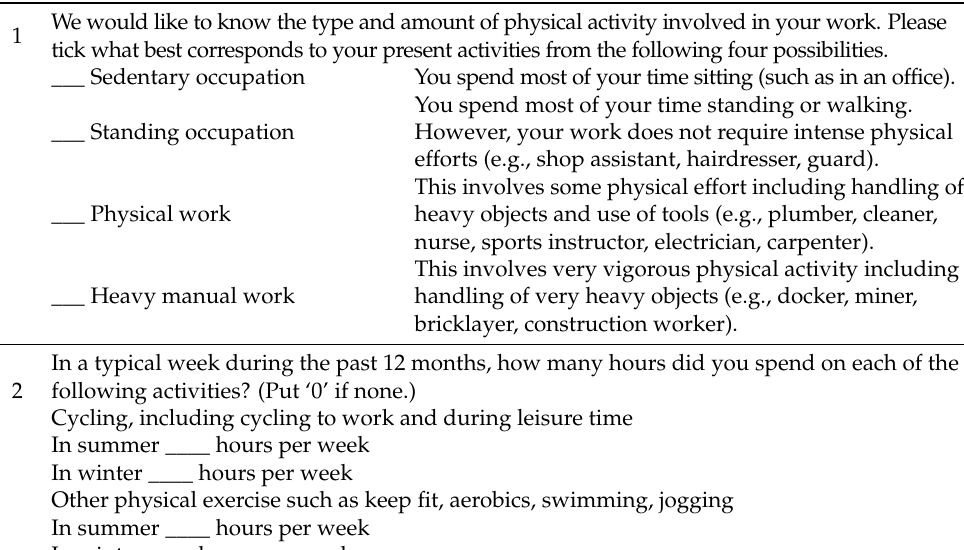
Table A1. EPIC Physical Activity Questions from which the Total Physical Activity Score was